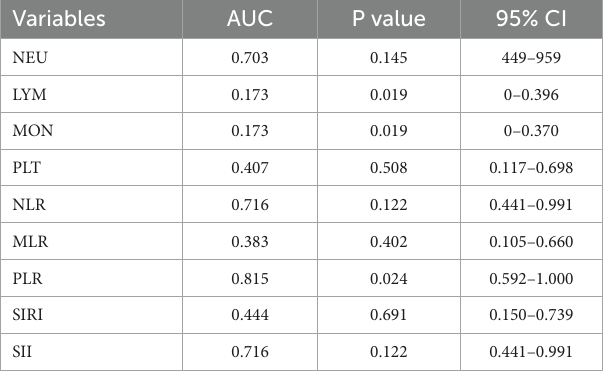
TABLE 5 ROC curve analysis for distinguishing active phase from remission phase.